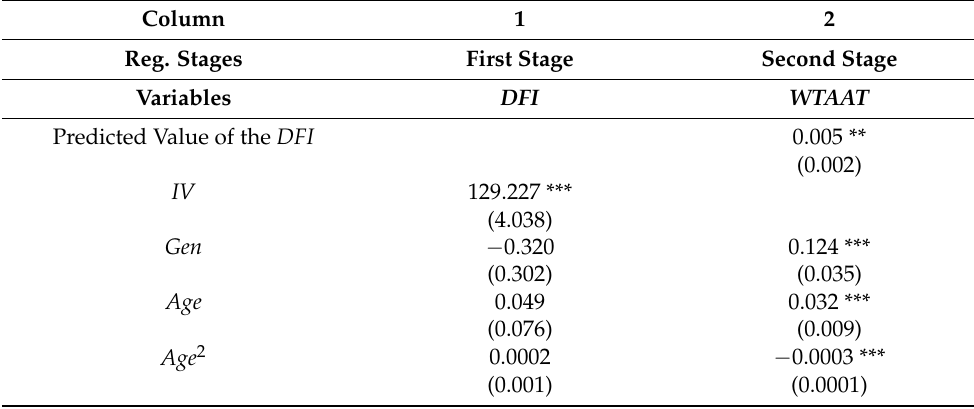
Table 3. Two-stage estimation results of instrumental